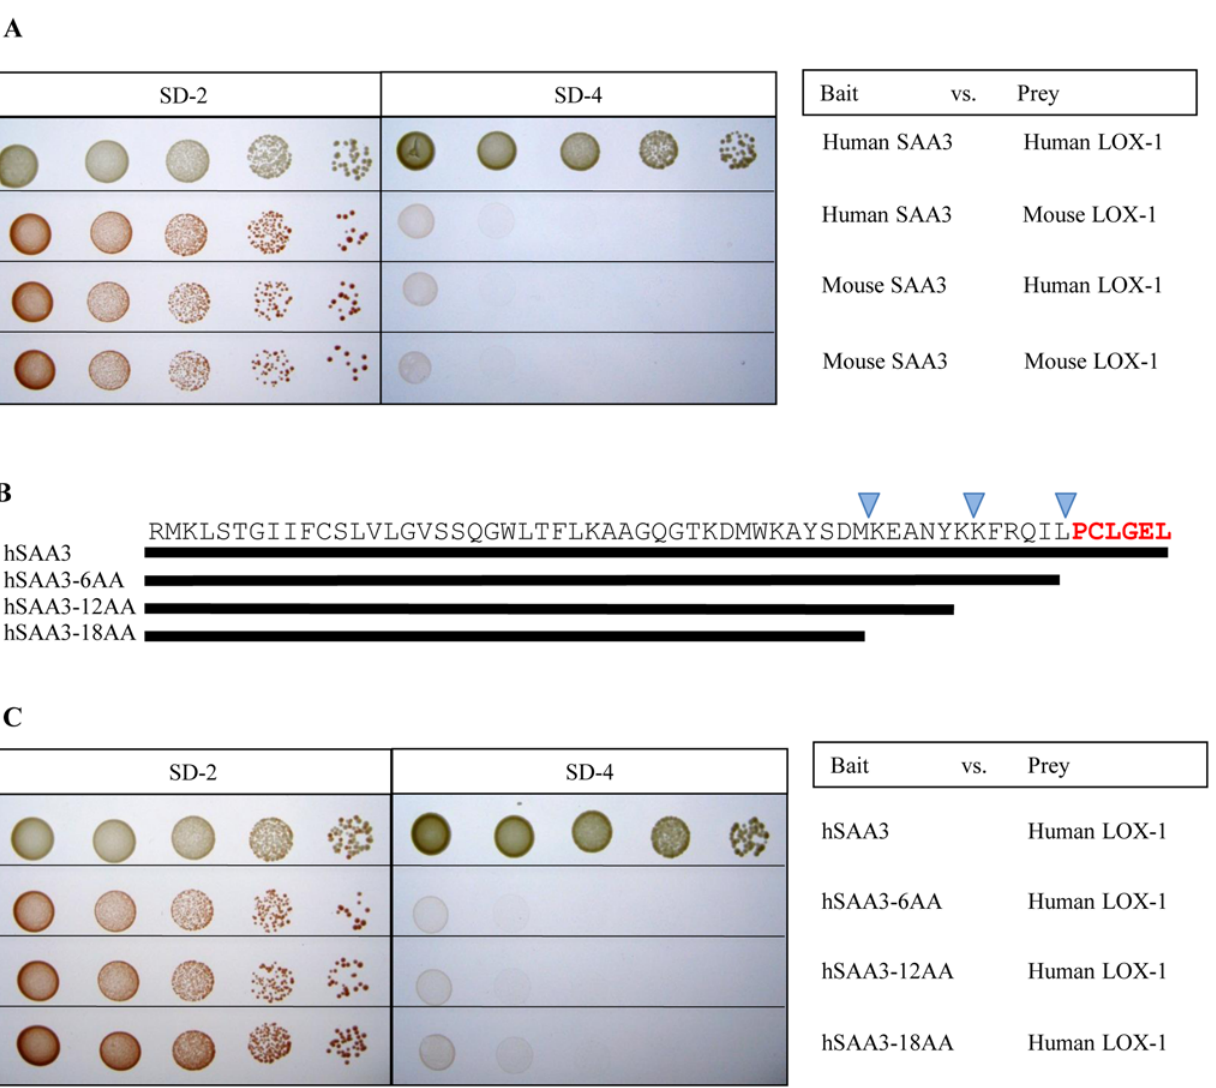
Fig 3. Yeast two-hybrid analysis for the interaction between SAA3 and LOX-1. (A) Bait constructs were the GAL4 DNA-binding domain fused to hSAA3 C-terminal 61 mer or mSAA3. Prey was the GAL4-activation domain fused to the human LOX-1 extracellular domain, or the mouse LOX-1 extracellular domain. The left panel shows the growth of transformed yeasts in synthetic dropout medium (SD-2; -Leu, -Trp). The middle panel indicates interactions between SAA3 and LOX-1 constructs (shown in the right panel) in SD-4 (-Leu, -Trp, -His, -Ade) in a series of dilutions (dilution increases from left to right). (B) Schematic representation of hSAA3 and its serial C-terminal deletion mutants. An actual amino acid sequence is also displayed. (C) Bait constructs were the GAL4 DNA-binding domain fused to hSAA3 C-terminal 61 mer (hSAA3), and its 6 (hSAA3 – 6AA), 12 (hSAA3 – 12AA), or 18 amino acid deletion mutant (hSAA3 – 18AA). Prey was the GAL4-activation domain fused to the human LOX-1 extracellular domain. The left panel shows the growth of transformed yeasts in the synthetic dropout medium (SD-2; -Leu, -Trp). The middle panel indicates interactions between SAA3 and LOX-1 constructs (shown in the right panel) in SD-4 (-Leu, -Trp, -His, -Ade) in a series of dilutions (dilution increases from left to right).